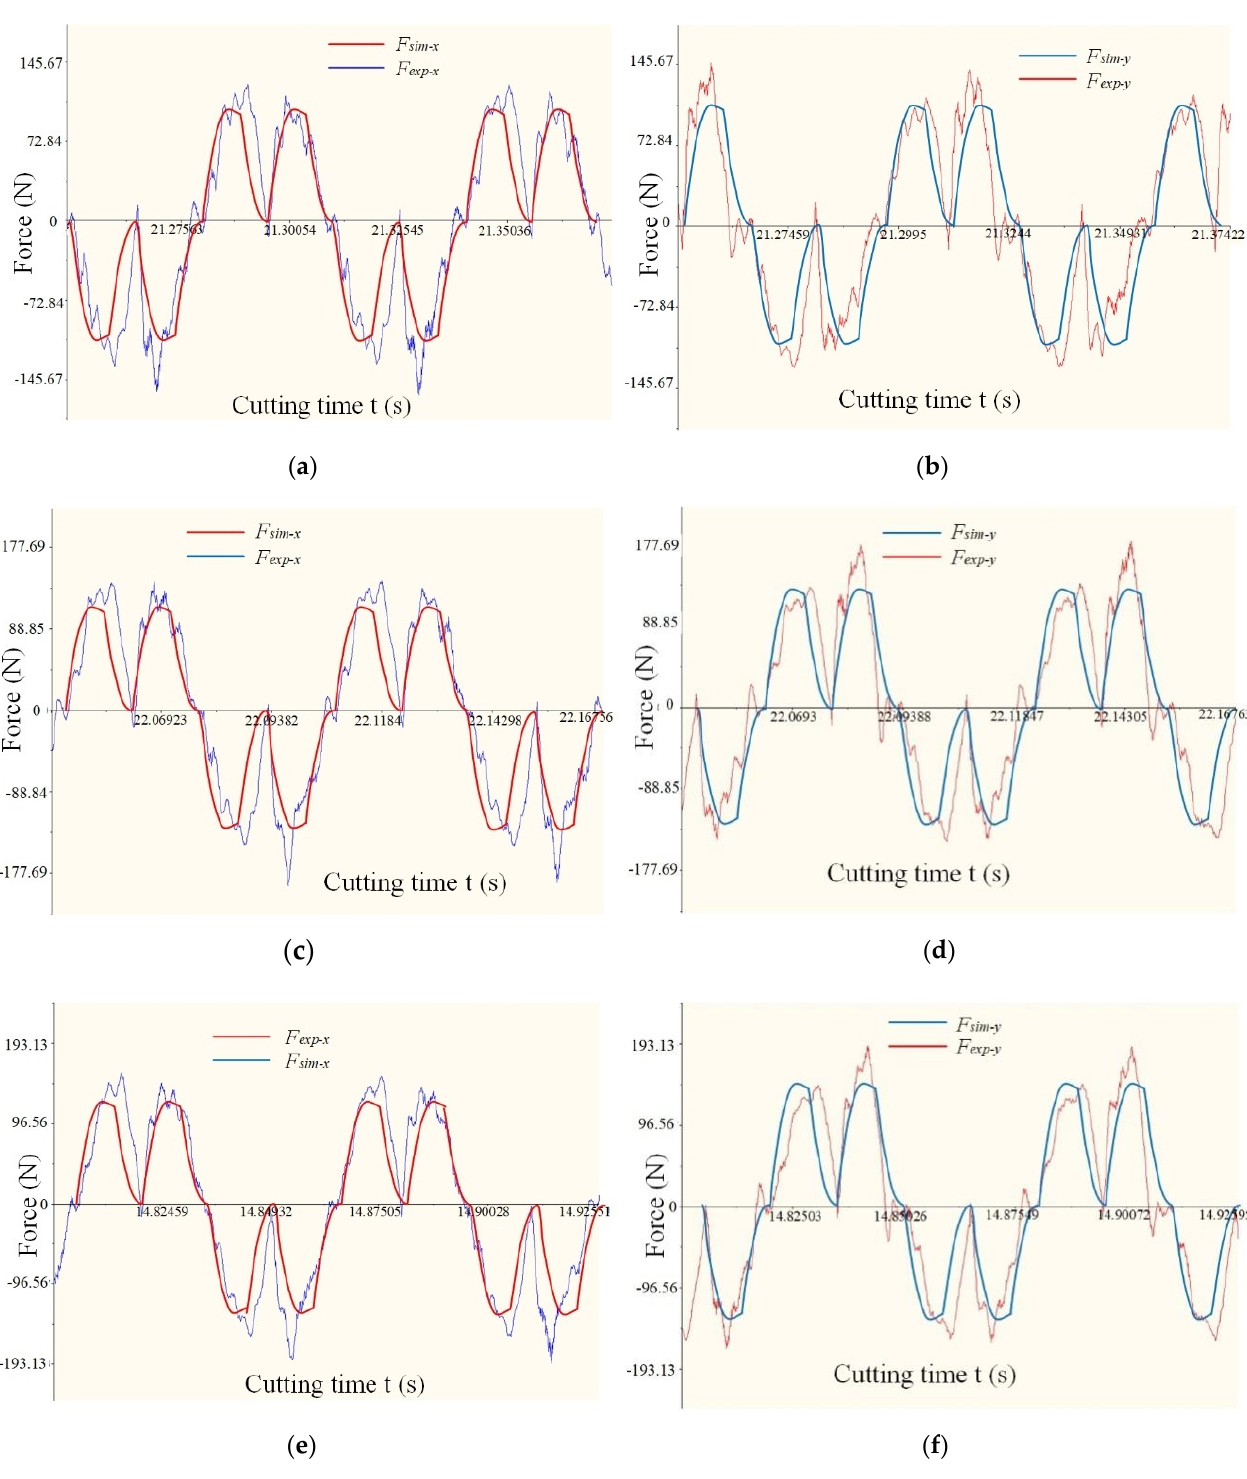
Figure 11. Experimental and simulation comparison of milling force. ( a ) The 1st set of X-Force. ( b ) The 1st set of X-Force. ( c ) The 4th set of X-Force. ( d ) The 4th set of X-Force. ( e ) The 6th set of X-Force. ( f ) The 6th set of X-Force.